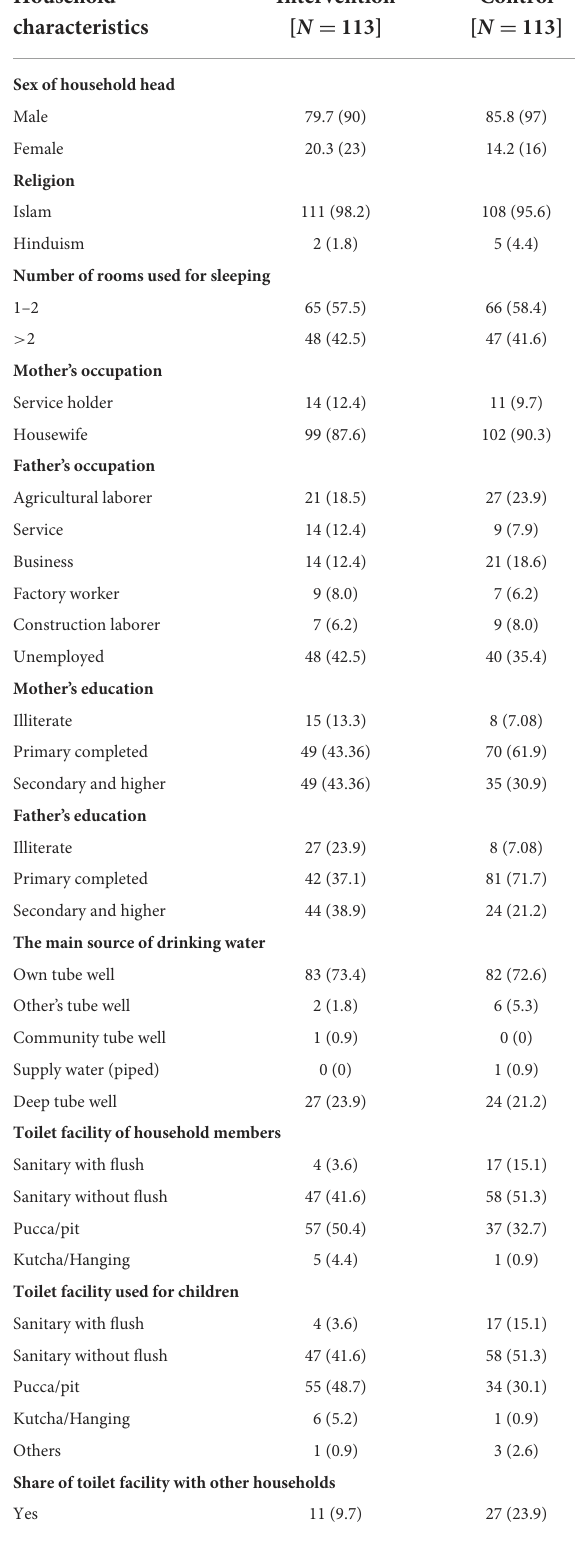
TABLE 1 Household characteristics of the participants by